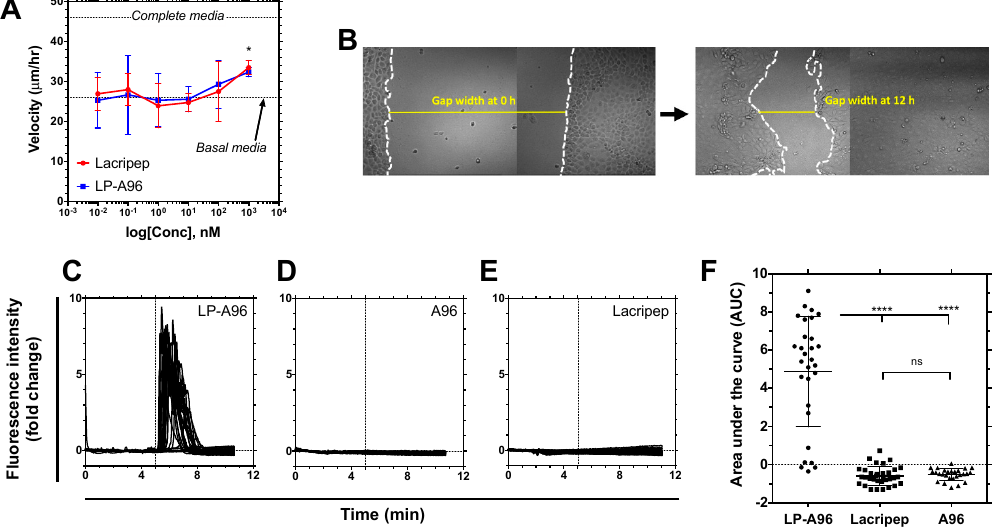
Figure 2. LP-A96 promotes scratch closure and induces Ca 2+ influx in corneal epithelial cells. ( A ) A scratch (gap) assay was used to observe the enhancement of cell motility. The velocity of cell monolayer towards the remaining gap area (devoid of cells) was calculated as outlined in ( B ). ( B ) Gaps were imaged before the treatment and at 12 h post-treatment, and used to construct ( A ). White dotted lines indicate the outer edges of the monolayer adjacent to the wound gap. ( C~E ) Human corneal epithelial (HCE-T) cells pre-incubated with Fluo-4 AM were incubated with either LP-A96, Lacripep, or A96 (all at 1 µ M). The dotted line at the 5th minute indicates when the treatment was added to the culture medium. The fluorescence intensity of Fluo-4 AM was monitored as a marker for Ca 2 + influx ( n = 27~33 cells / treatment per experiment). A representative data set from the three independent sets of the experiment is shown. ( F ) The area under the curve of each fluorescence intensity profile shown in ( C ~ E ) showed that only LP-A96 extensively mobilized Ca 2 + . A one-way ANOVA followed by multiple comparisons was used for statistical comparison. **** p < 0.0001, * p < 0.05, ns: non-significant. Mean ± SD.